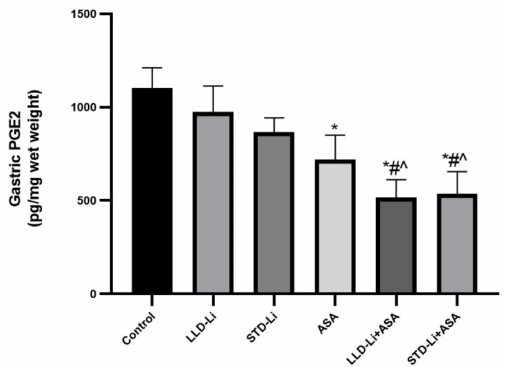
Figure 7. Gastric mucosal PGE2 levels in aspirin + Li-treated rats. Rats were fed regular food